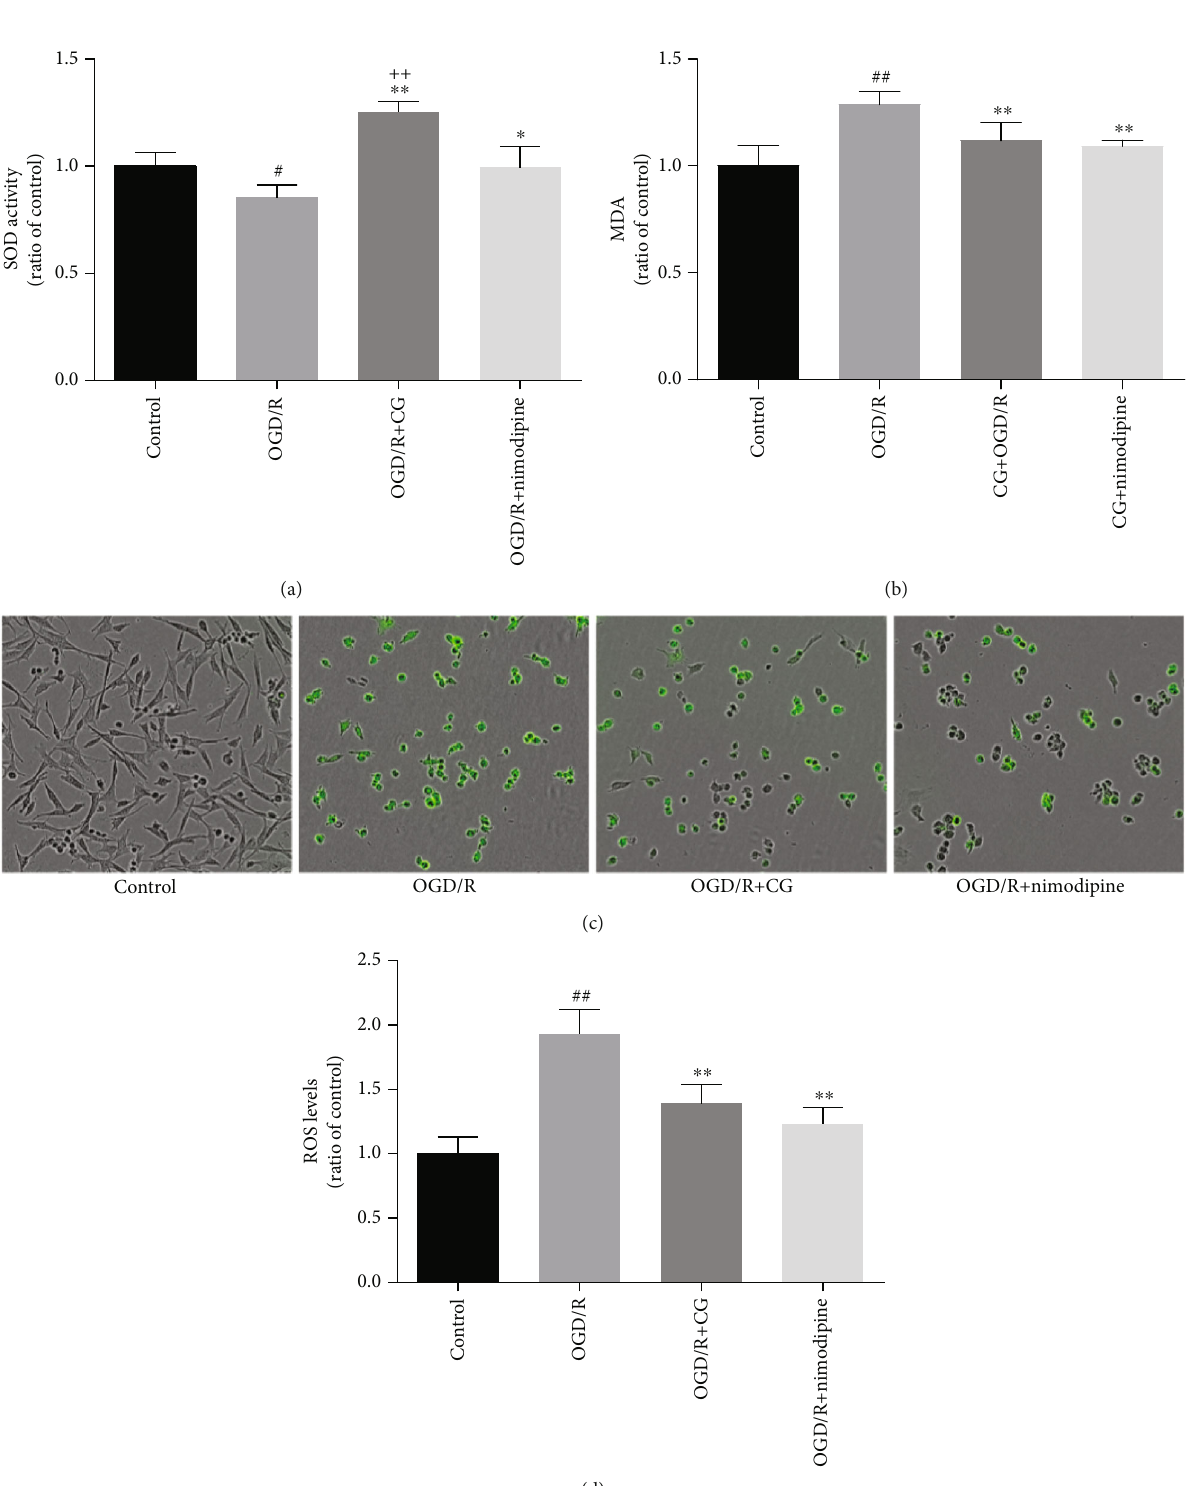
Figure 3: HT22 cells were treated with 8 h of OGD and then reoxygenated in the presence of CG for 6h. CG elevated the SOD activity and reduced the MDA level and ROS generation: (a) SOD activity; (b) MDA level; (c) ROS fl uorescence intensity; (d) ROS level. Three independent experiments were performed, and data were expressed as the mean ± SD . # P < 0 : 05 , ## P < 0 : 01 vs. control group; ∗ P < 0 : 05 , ∗∗ P < 0 : 01 vs. OGD/R group; ++ P < 0 : 01 vs. nimodipine